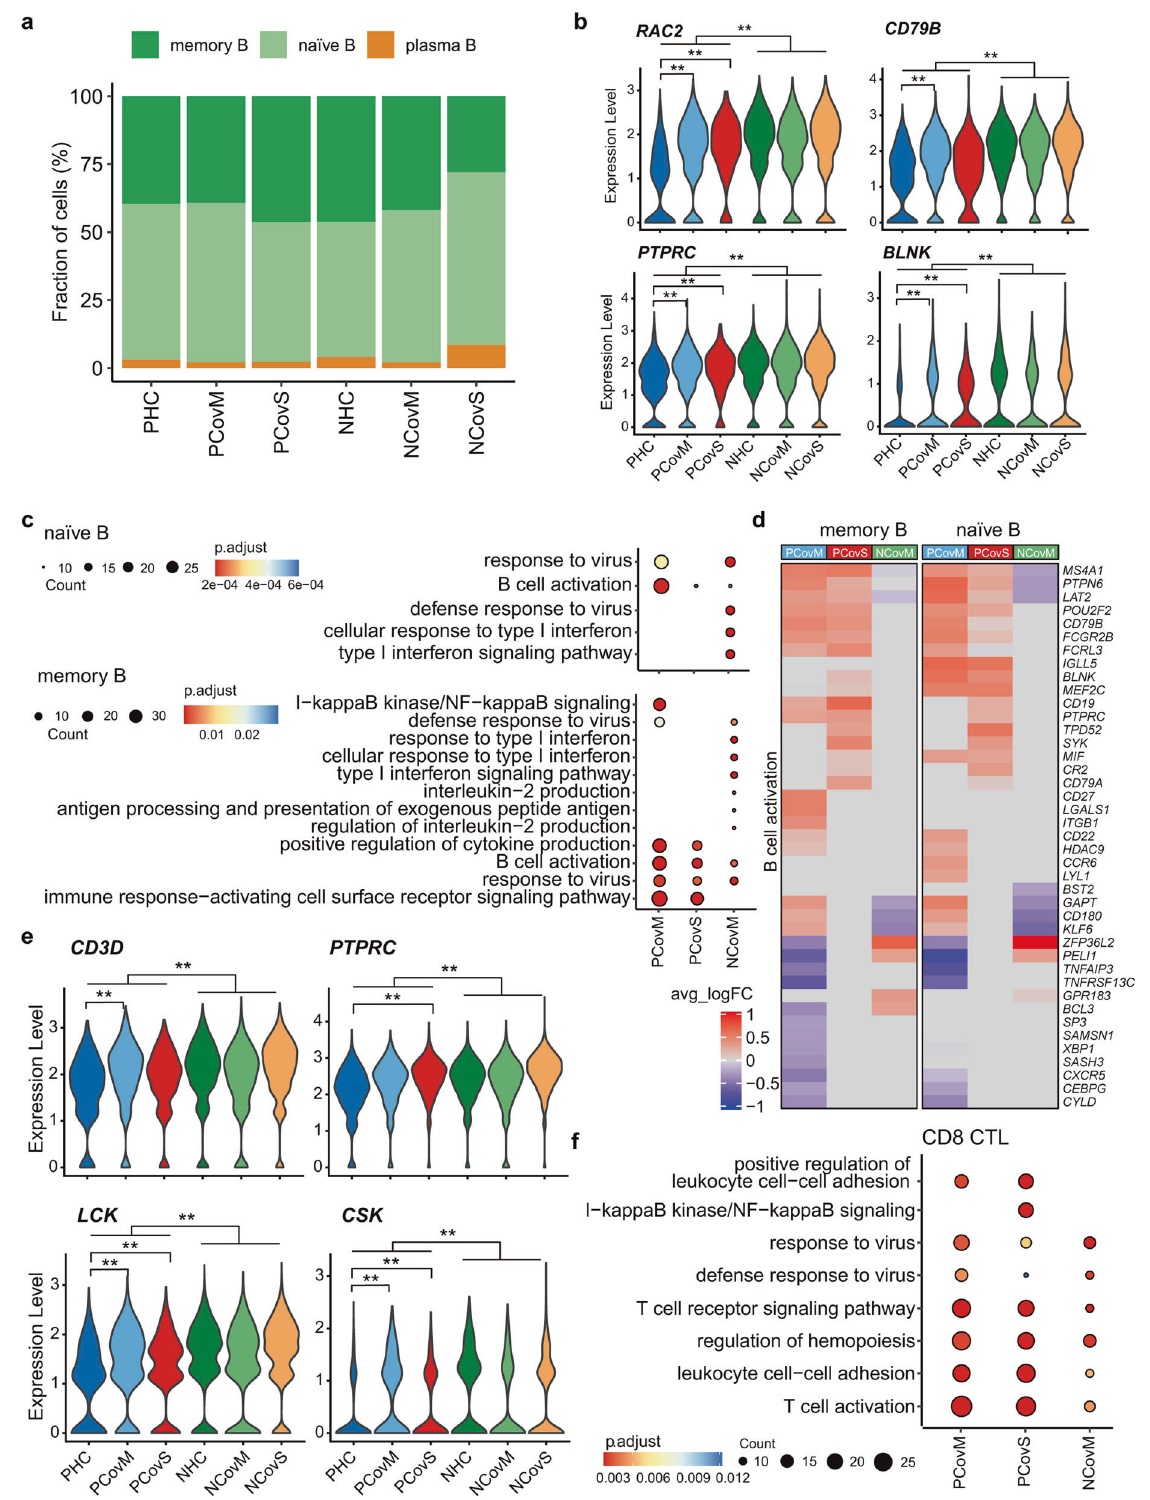
Fig. 3 Enhanced activation in the lymphoid cells of pregnant COVID-19 patients. a Percentages of B cell subtypes from the PHC, PCovM, PCovS, NHC, NCovM, and NCovS groups. Violin plots showing the expression of genes involved in BCR signaling in memory B cell ( b ) or TCR signaling in CD8 CTL ( e ). * p < 0.05, ** p < 0.01, Wilcoxon rank-sum test, adjusted for Bonferroni post hoc test. Top GO terms and pathways enriched for DEGs in naive B, memory B ( c ), or CD8 CTL ( f ) cells. Color scale indicates adjusted p values, which was derived from a hypergeometric test. The size of symbols is in proportion to gene counts enriched in the corresponding GO terms. d Heatmaps of DEGs enriched in “ B cell activation ” pathway for memory B and naive B cell cells. The color scale indicates the average log (fold change over the healthy controls) of representative genes